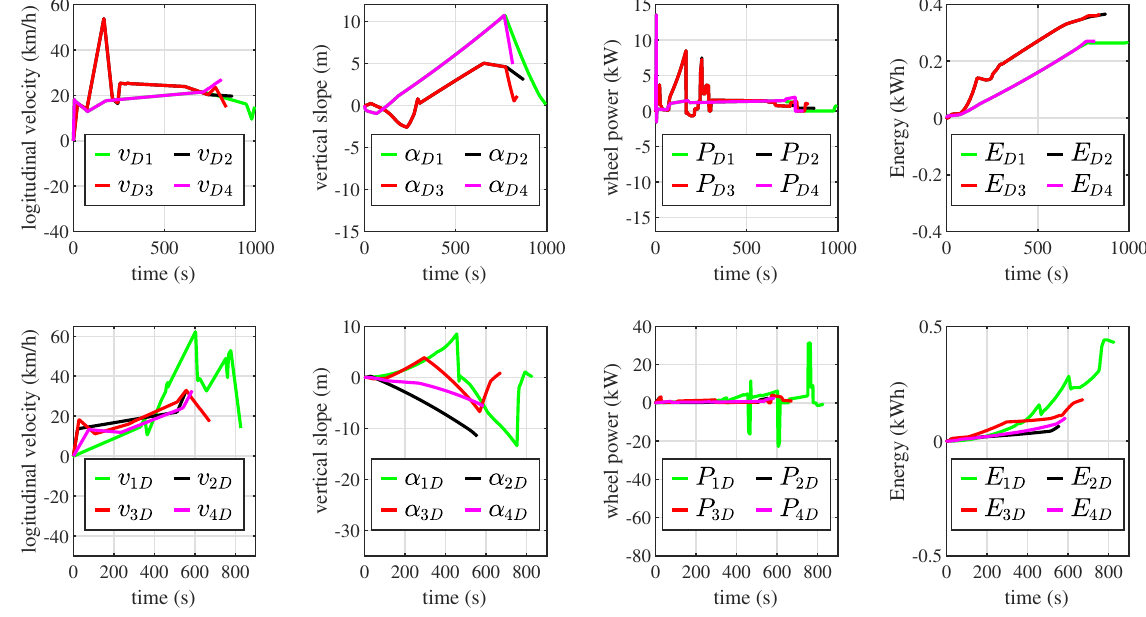
Figure 8. Travels from depot to customers and from customers to